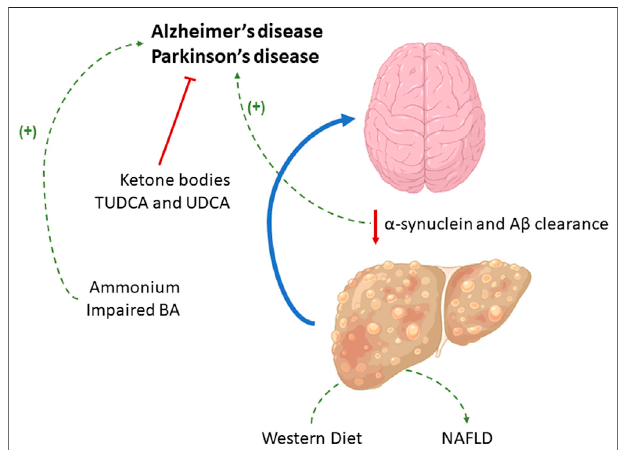
GRAPHICAL ABSTRACT | The role of the liver in the metabolism of toxic compounds and in A β and α -synuclein clearance is related to neurological disorders such as Alzheimer ’ s Disease (AD) and Parkinson ’ s Disease (PD) development, although the supplementation with certain compounds may exert a protective effect. The current Western diet and alterationsintheBApro fi le,whosehomeostasisiscontrolledbytheliver,have been also related to both AD and